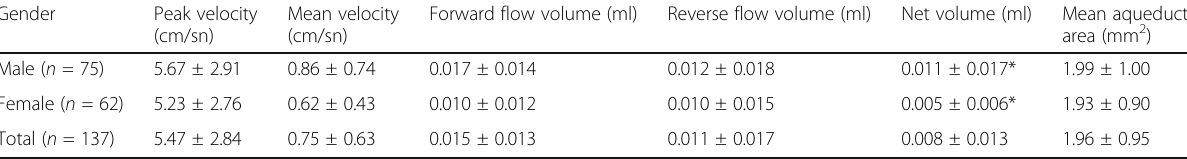
Table 1 A comparative overview of phase contrast MRI parameters in females and males